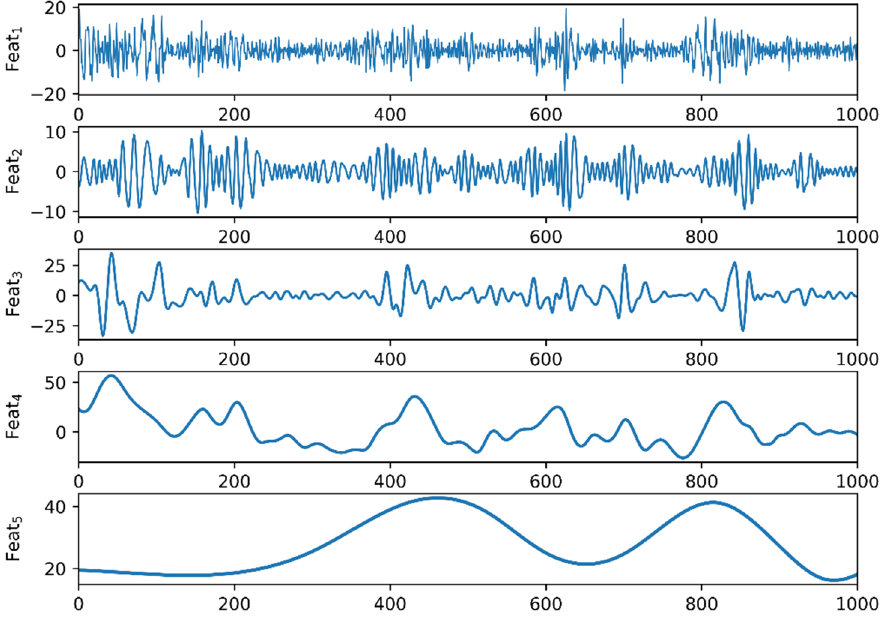
Figure 5. Subsequence after decomposition and reconstruction of CEEMDAN-FE (partial).